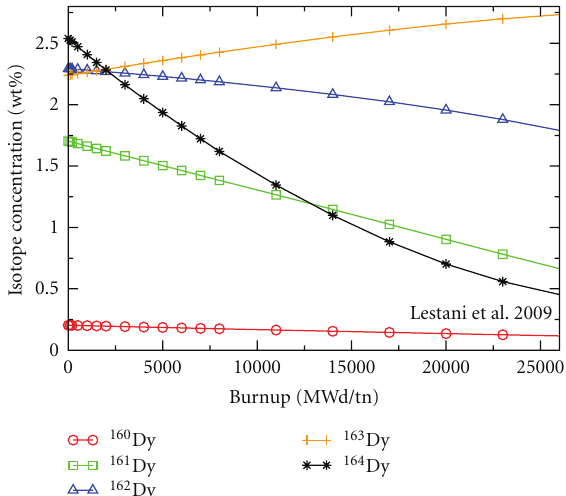
Figure 4: Dy isotopes weight percent evolution with